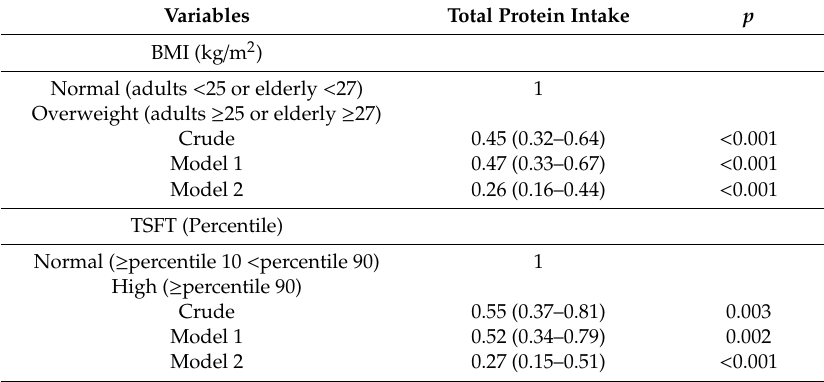
Table 3. Association (Odds ratio) between total protein intake with anthropometric measurements and blood glucose